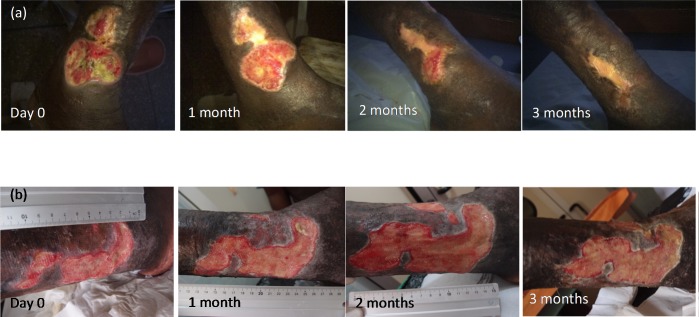
a) Uncomplicated IS2404 PCR positive ulcer of the left ankle of a patient at the PHC center; b) non-healing IS2404 PCR positive ulcer of the right leg of a patient at the SHC center.